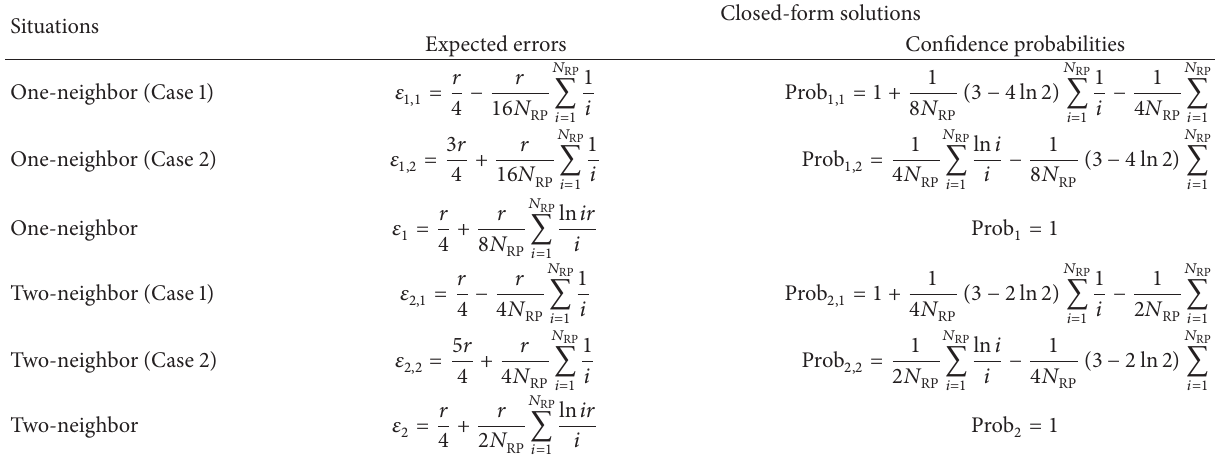
Figure 11: Results of static positioning errors by all the APs. Table 1: Statistical errors by RADAR neighbor matching